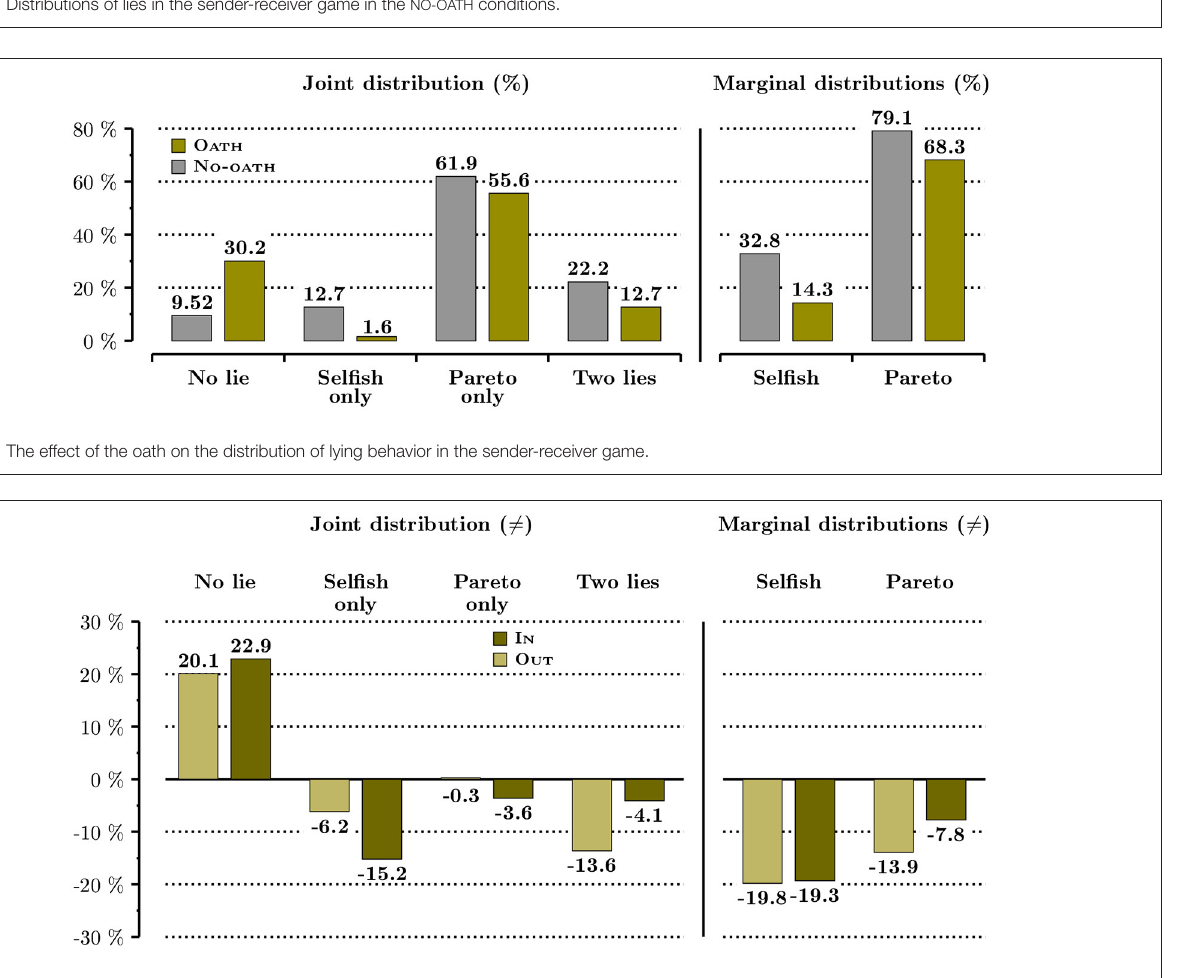
FIGURE 4 | Distributions of the marginal effect of the